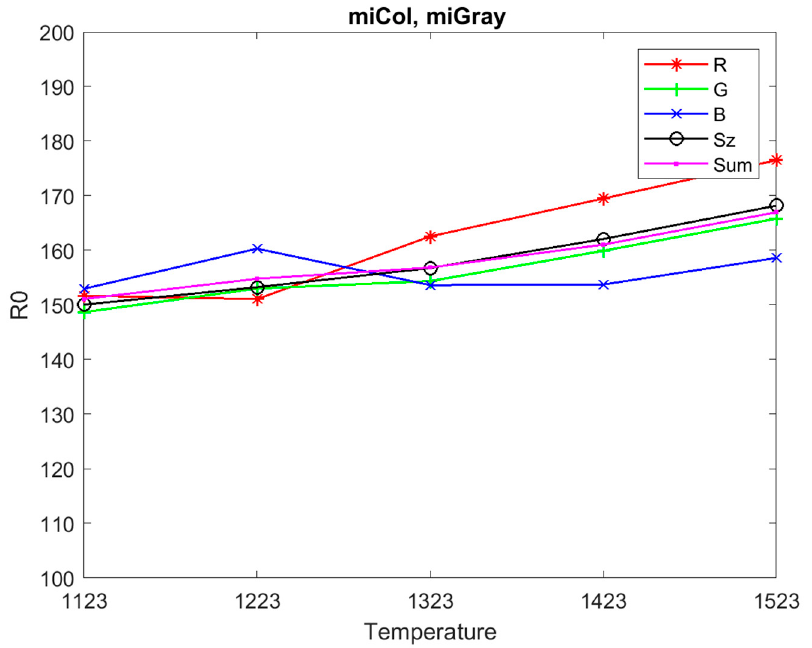
Figure 12. Change of average values of histograms as a function of blade heating temperature, where: Sum = (R + G + B)/3.